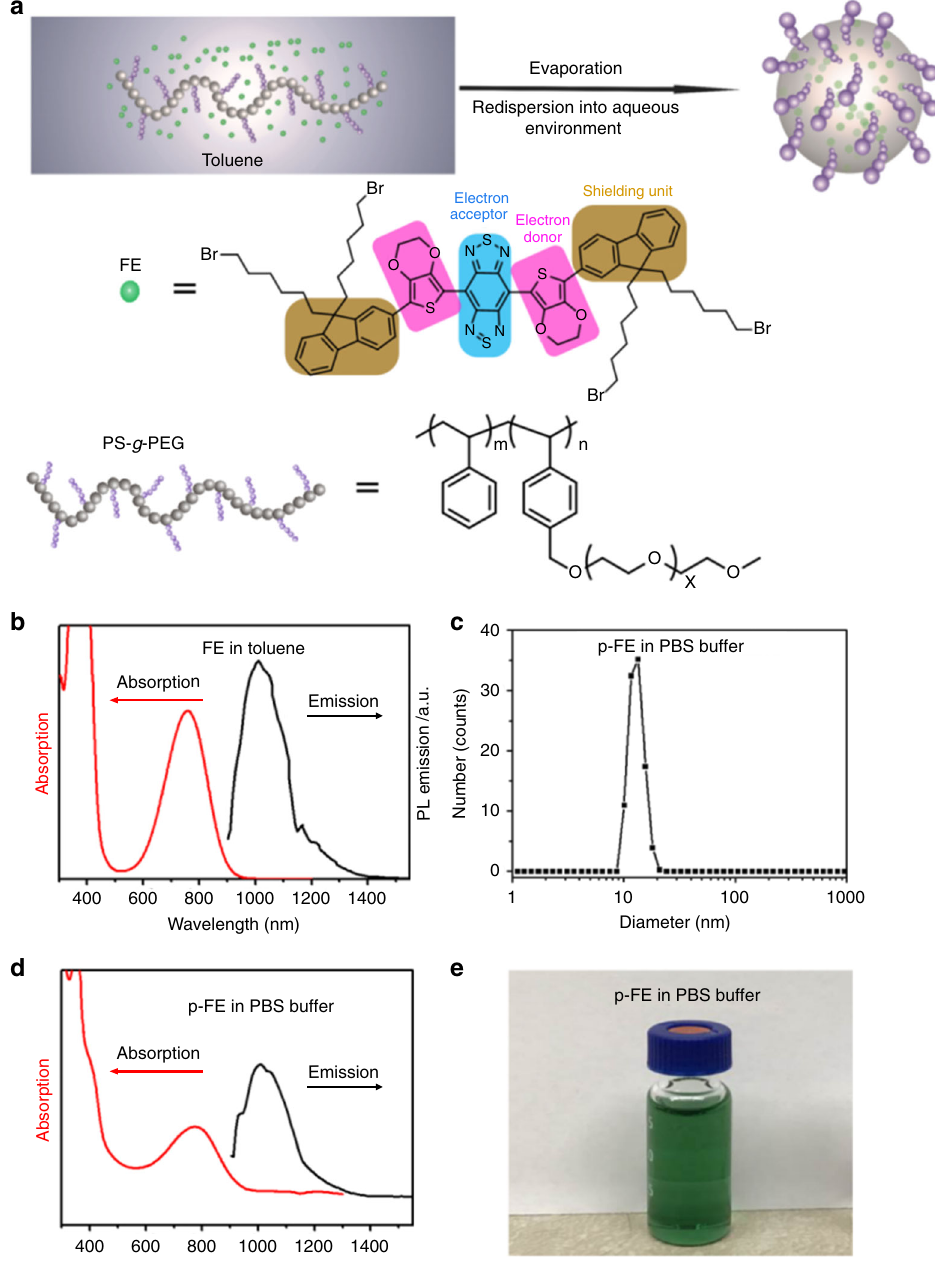
Fig. 1 Synthesis and characterization of p-FE. a Scheme of p-FE synthesis and chemical structures of FE and the PS- g -PEG polymer. b Absorption and emission spectra (excited by an 808 nm laser) of FE in toluene. c Dynamic light scattering (DLS) analysis of p-FE in PBS buffer. d Absorption and emission spectra (excited by an 808 nm laser) of p-FE in PBS buffer. e Photo of p-FE dispersed in PBS buffer. Mw of PS- g -PEG is around 23000g moL −